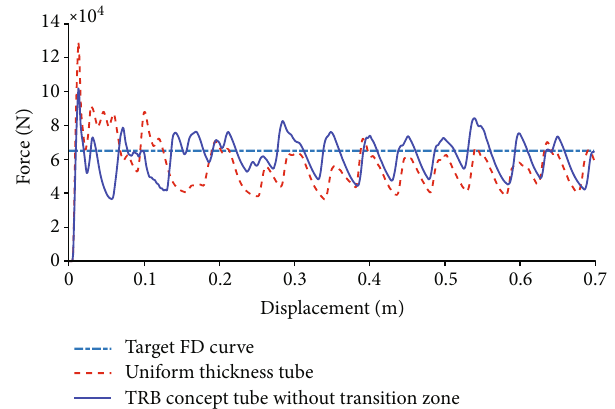
Figure 14: The FD curve of the uniform thickness tube and TRB concept tube without transition zone.